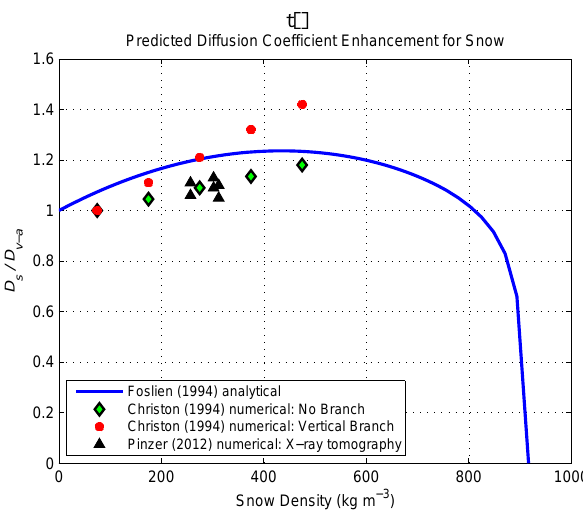
Figure 7. Effective diffusion coefficient enhancement for snow pre- dicted by Foslien (1994) vs. finite element predictions of Christon (1990) and Pinzer et al. (2012).